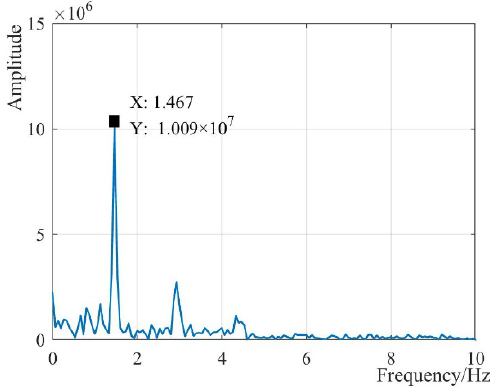
Figure 5. The pulse wave spectrum.